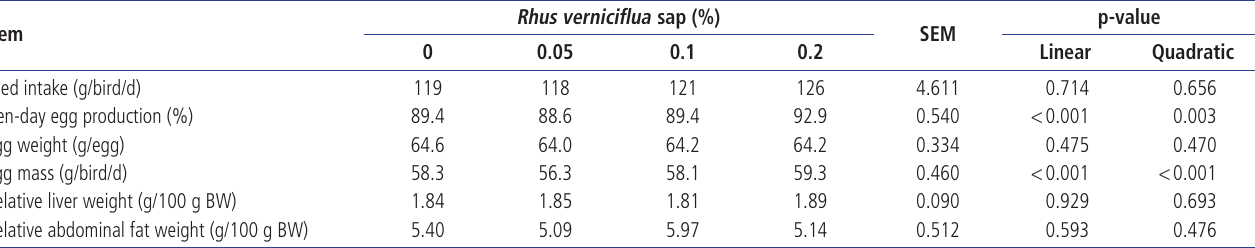
Table 2. Effects of dietary detoxified Rhus verniciflua sap on egg performance and relative organ weights in laying hens Item